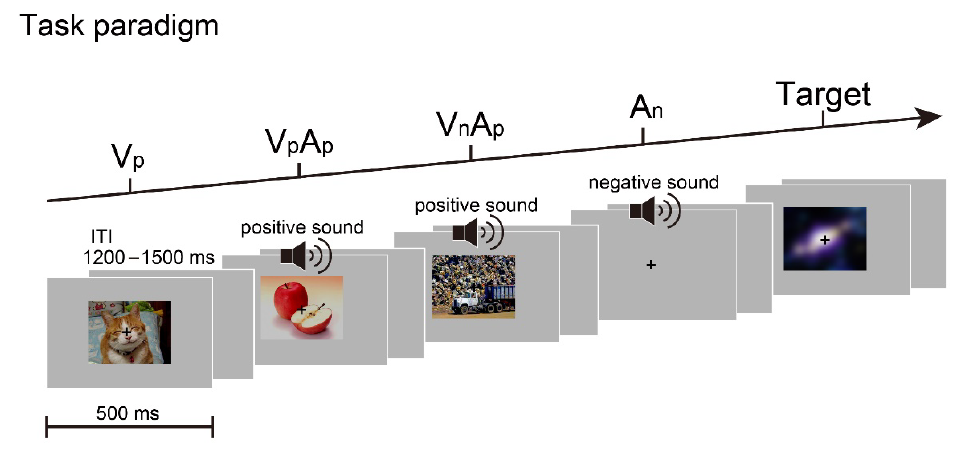
Figure 1. Task paradigm shown for four non-target trials and one target trial. A non-target trial could be an emotionally positive or negative visual or auditory stimulus presented alone [e.g., a positive picture (V p ) or a negative sound (A n )], or the two stimuli presented synchronously (VA) to form an audiovisual pair being either emotionally congruent [e.g., a positive picture paired with a positive sound (V p A p )] or emotionally incongruent [e.g., a negative picture paired with a positive sound (V n A p )], resulting in eight sub-types of non-target stimuli. A target trial could be a blurred picture presented alone or presented synchronously with an emotionally positive or negative sound, resulting in three sub-types of target stimuli. The task for participants was to press a button in response to the target stimuli, while ignoring all sounds if delivered. Each type of trial consisted of a 500 ms stimulus presentation and an inter-trial interval (ITI) of 1200–1500 ms.